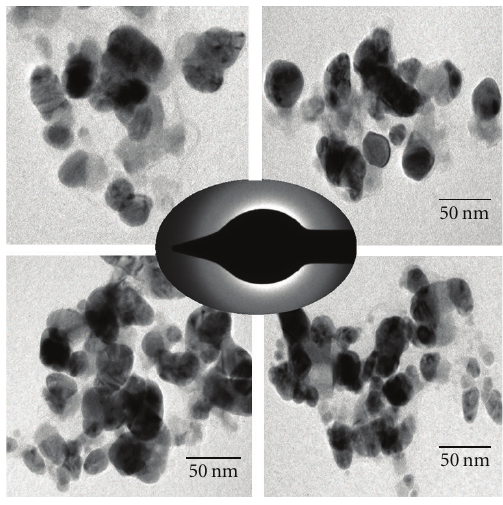
Figure 6: TEM images of AgNP.